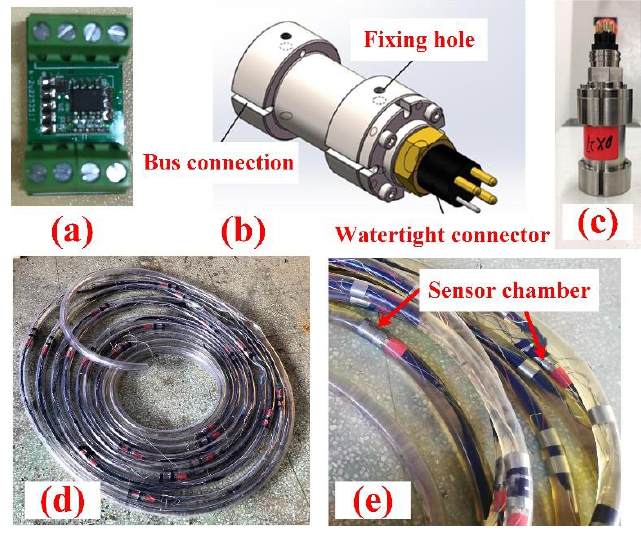
Figure 4. ( a ) MEMS-IMU; ( b ) Sensor chamber model; ( c ) Physical objects; ( d ) Oil-filled cable; ( e ) Sensor chambers in cable. Table 1. The main parameters of the MEMS